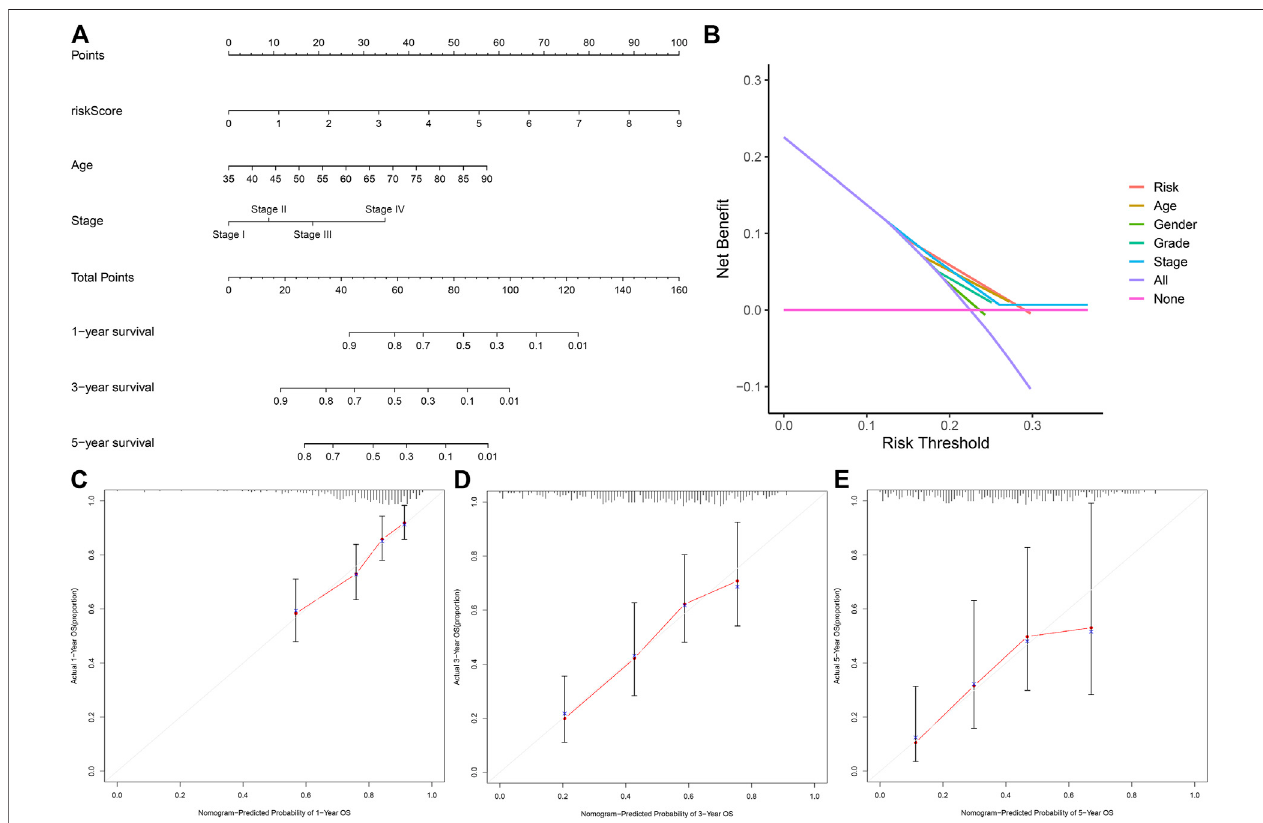
FIGURE 5 | The nomogram for predicting the OS of STAD patients at 1, 3, and 5 years. (A) Construction of the nomogram comprising independent prognostic factors (age, stage, and RS). (B) DCA curves for assessment of the clinical utility of the nomogram. (C – E) The Calibration curves of the nomogram for predicting the probability of OS at 1, 3, and 5